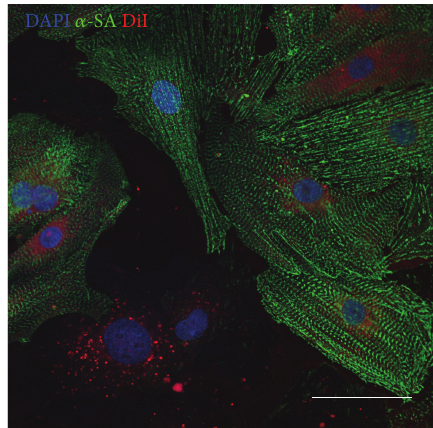
Figure 3: NRCMs cultured in vitro uptake DiI-labeled hCSC- XOs (red). The CSC-XOs can be seen within the cytoplasm of the cardiomyocytes (green). Scale = 50 𝜇